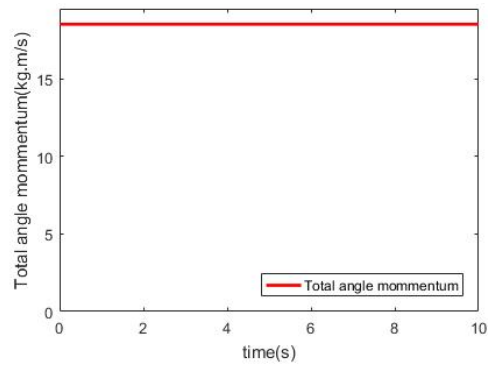
Figure 6. Total angular momentum.